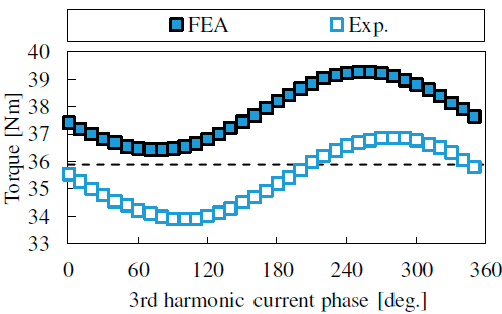
Figure 21. Output torque amplitude with 3rd harmonics.